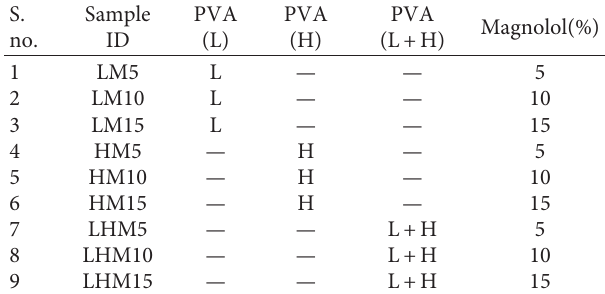
Table 2: Composition of magnolol-based PVA films. S.